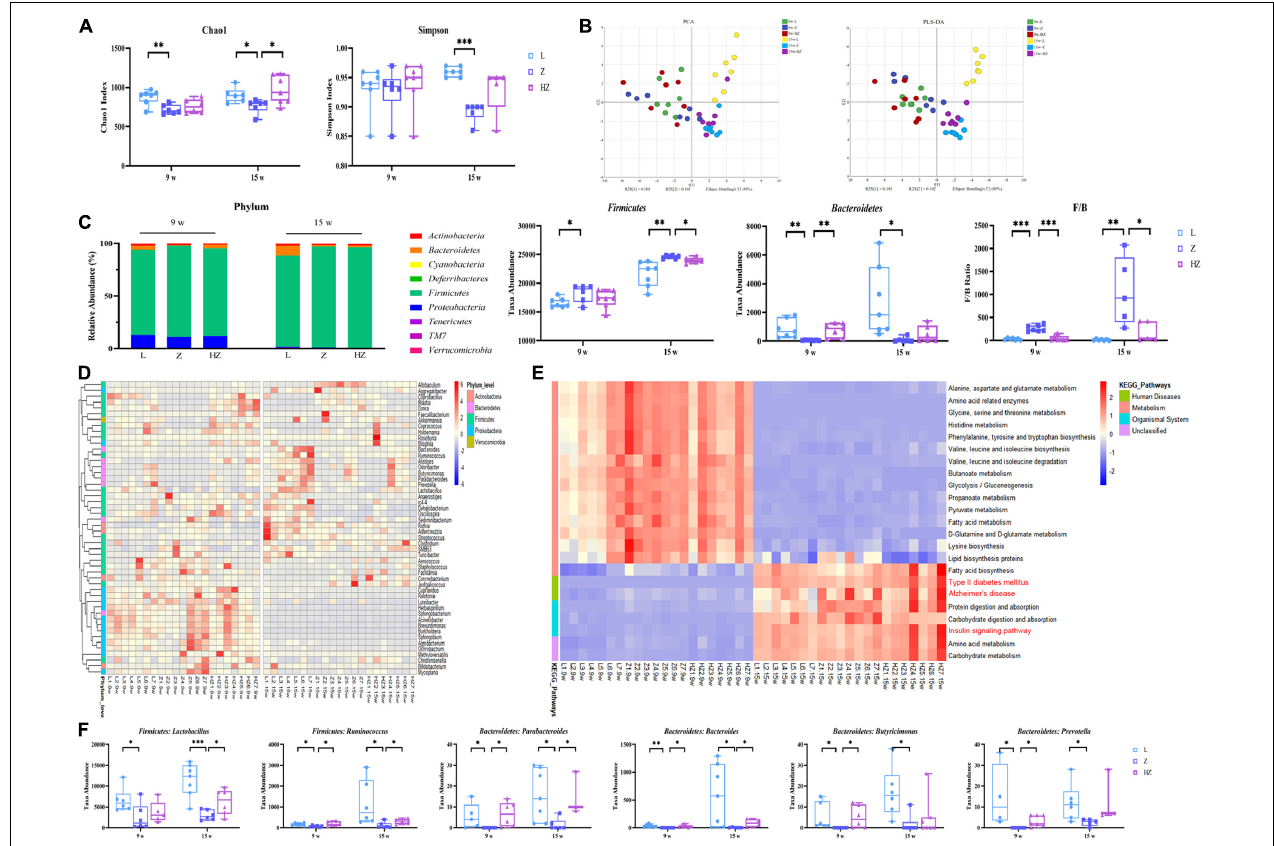
FIGURE 4 | Effect of ZBPYR treatment on the gut microbiota of rats. (A) Chao 1 index and Simpson index. (B) Microbiota community analysis based on PCA and PLS-DA score plots. (C) Bacterial taxonomic composition profiling of gut microbiota at the phylum level. (D) Hierarchical clustering heatmap of the top 50 differentiated taxa at the genus level. (E) KEGG metabolic pathway prediction by PICRUSt analysis. (F) Abundance of the key differentiated taxa in different groups. n = 7 per group. * p < 0.05, ** p < 0.01, *** p < 0.001. PCA, principal component analysis; PLS-DA, partial least squares discriminant